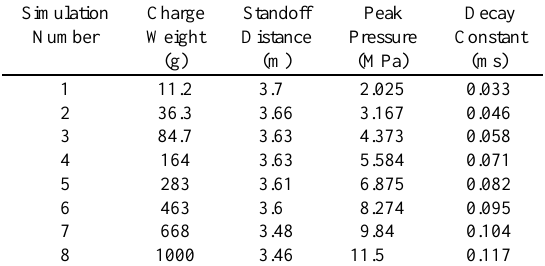
Fig. 3. Schematic diagram showing positioning of transducers on the test plates. P1 to P5 indicate the locations of the flush-mounted pressure transducers; A1 and A2, the accelerometers; SX1 and SX2, the surface-mounted strain gauges (aligned in the direction shown) and D1, the displacement transducer. Two additional strain gauges, SI1 and SI2 are mounted on the reverse, dry surface of the test plates in back-to-back positions to their SX1 and SX2 strain gauge counterparts, respectively. Table 1 Experimental parameters used for the eight LS-DYNA/USA simula-